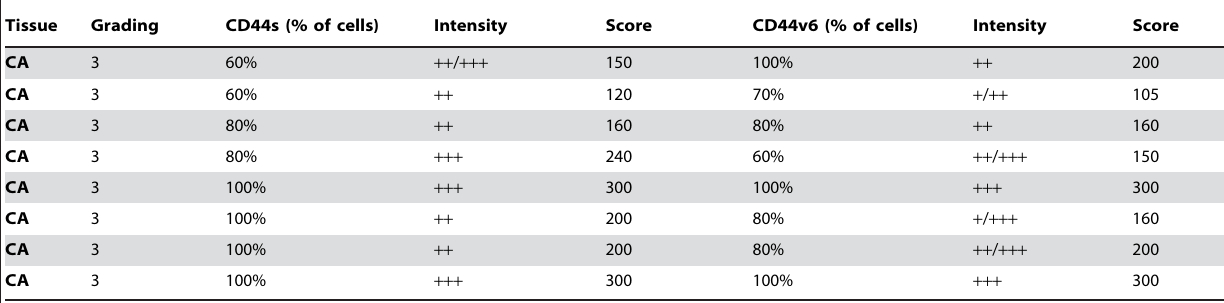
2 no staining; + weak; ++ moderate; +++ strong. The score incorporates the percentage of cells expressing the given antigen multiplied by the staining intensity (0–3). Grading is according to UICC convention.